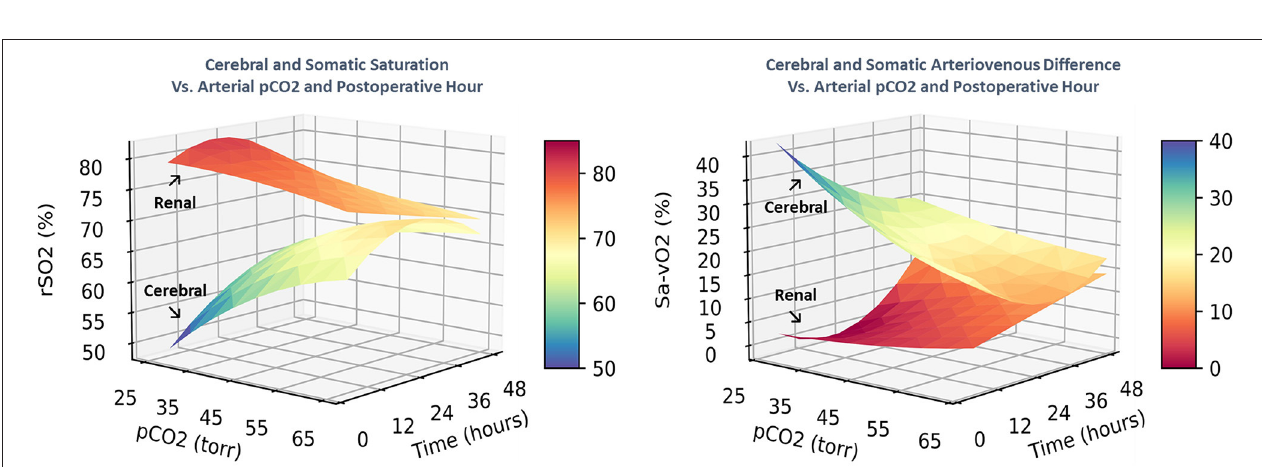
FIGURE 5 | The combined effects of postoperative time and PaCO2 on regional saturation and arteriovenous difference are displayed as 3-dimensional surfaces. The differential circulatory controls on cerebral and renal circulatory beds are characterized by distinct spatial regions with different